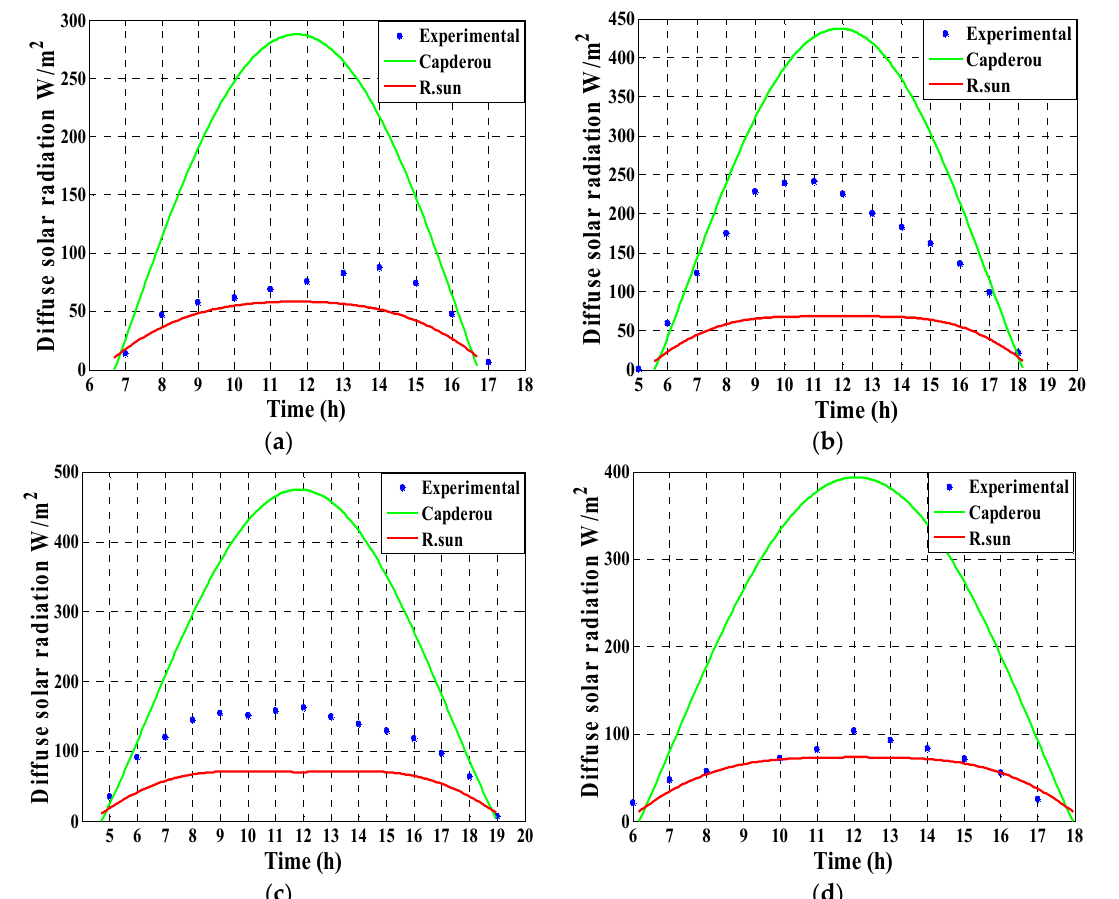
18 of 25 Figure 10. The comparison between the measured global solar radiations and the global solar radiation obtained by Capderou and R.Sun models for the site of Tlemcen. ( a ) 22 January 2006; ( b ) 8 April 2006; ( c ) 29 June 2006; ( d ) 26 September